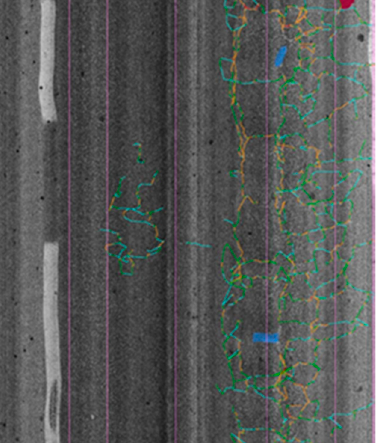
Figure 3. Pavement distress detected (severity = color code).